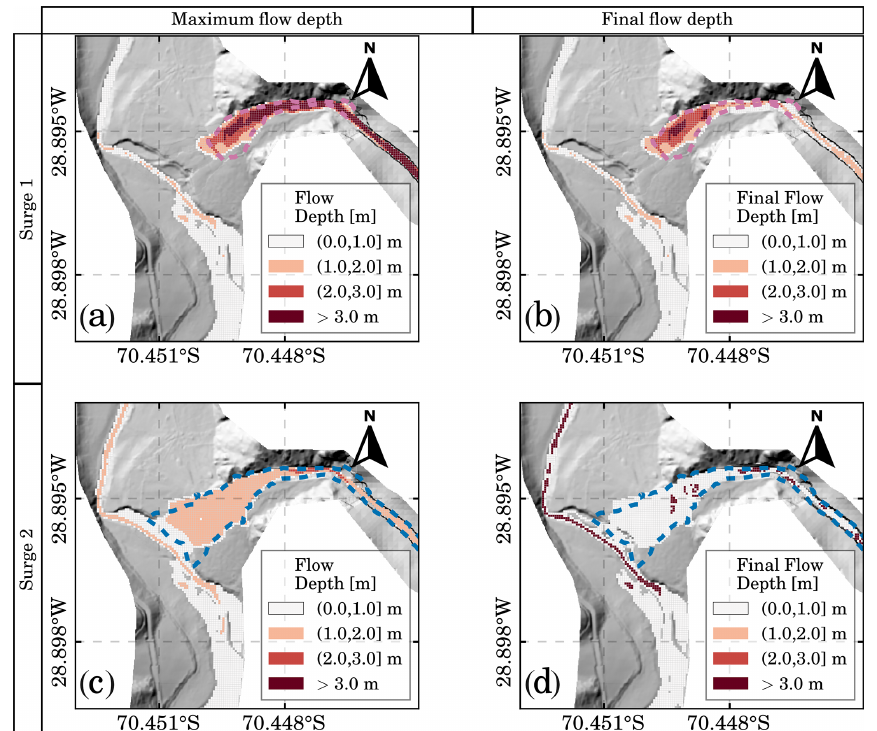
Figure 5. Viscous debris flow surges. Panels (a, b) correspond to the results for surge 1, whereas panels (c, d) correspond to the results for surge 2. Dashed polygons show the extent of mapped facies F1 (blue) and F2 (red). Panels (a, c) present the maximum flow depth, whereas panels (b, d) present the final flow depth at the end of each surge. Topographic changes for subsequent surges are updated based on the final flow depth of the previous surge.